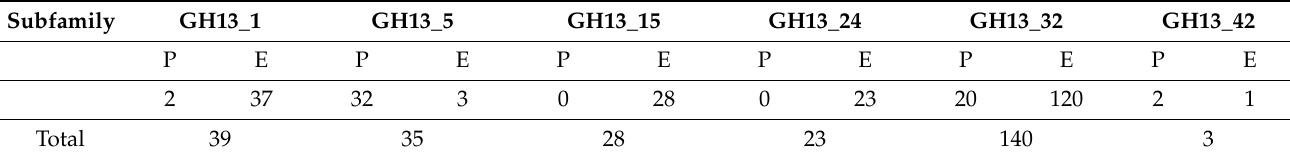
Table 1. Summary of 268 fungal and chloride-dependent α -amylases from the family GH13 used in the present study 1 .